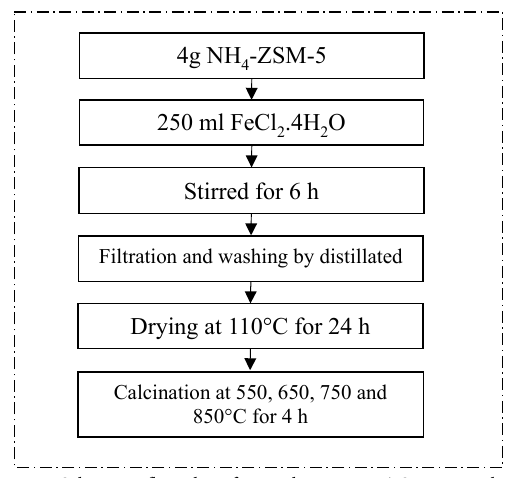
Fig. 1. Schematic flow chart for synthesizing Fe-ZSM-5 samples